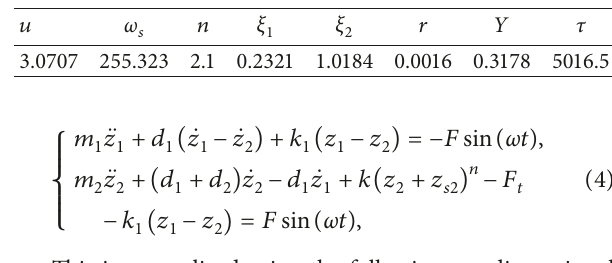
Figure 5: Field test of the vibrator: (a) the EV56 vehicle; (b) accelerometer located on the reaction mass. Table 1: Nondimensional system parameters of the field